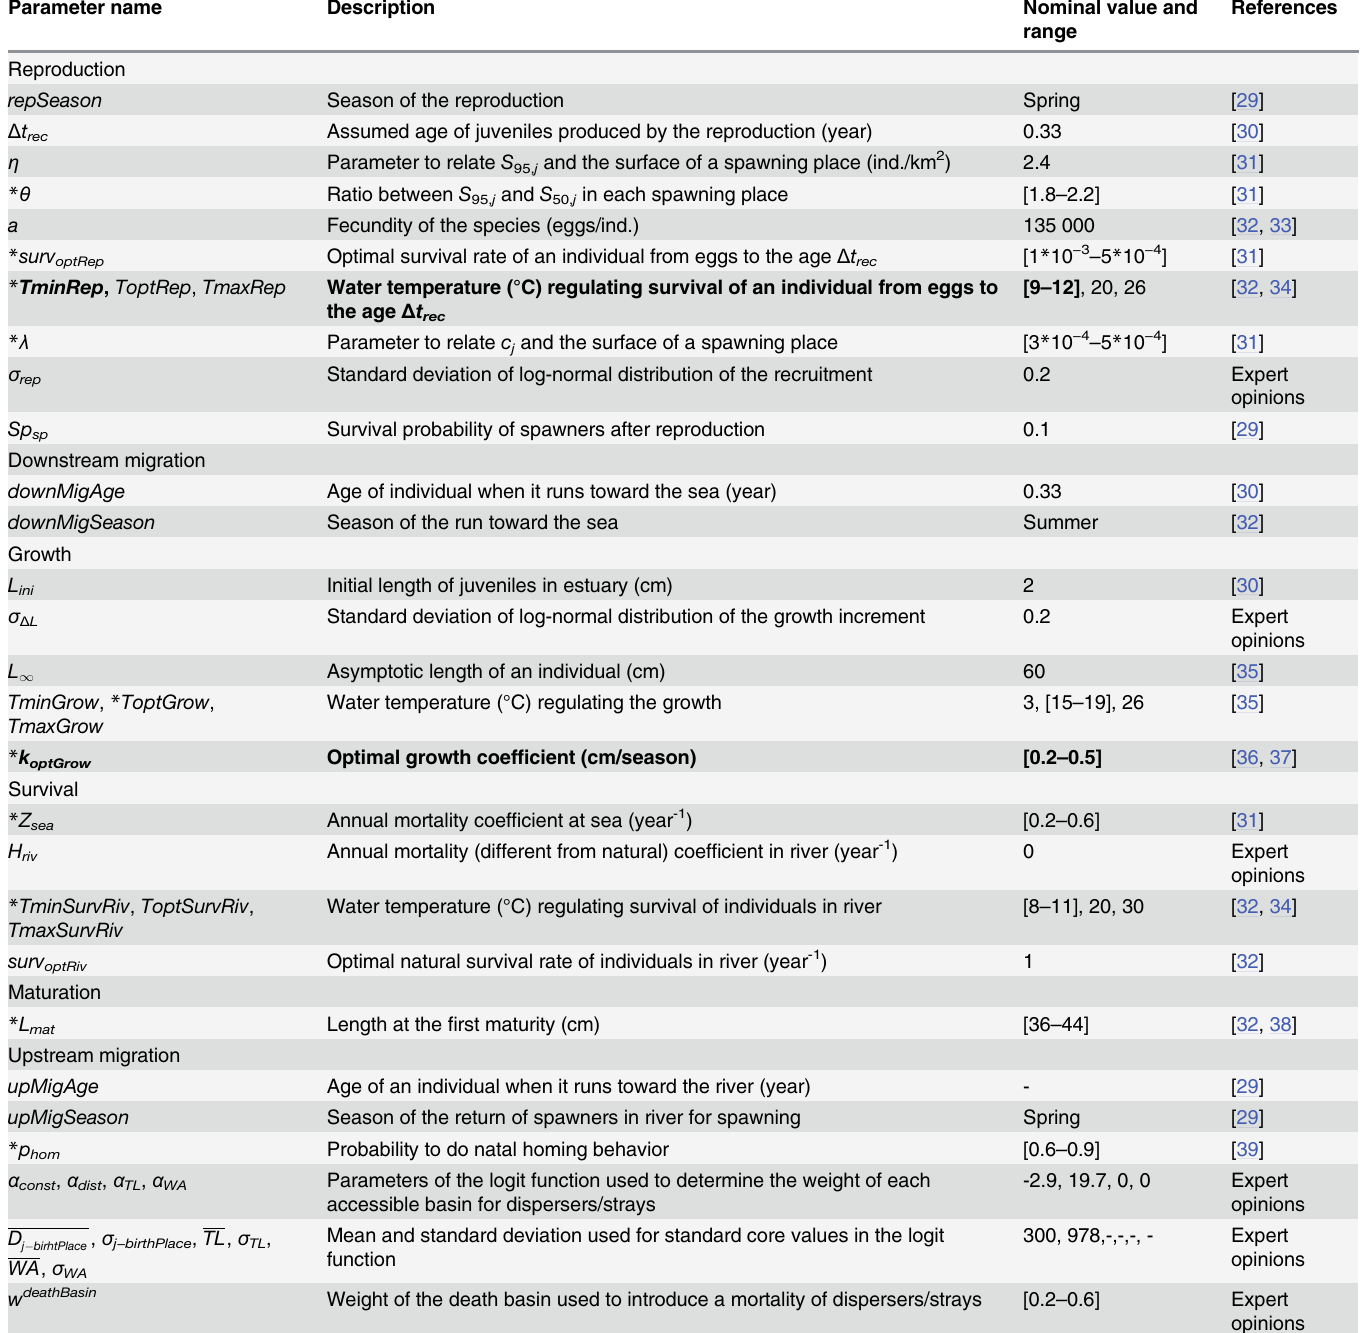
Table 1. GR3D parameter description with nominal values and ranges (minima and maxima) for the 11 parameters involved in the sensitivity